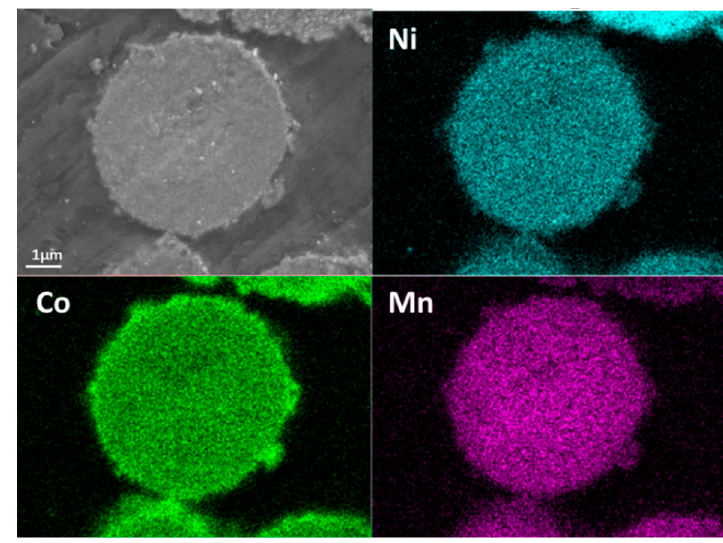
Figure 10. SEM mapping images of particles with a core-shell structure.